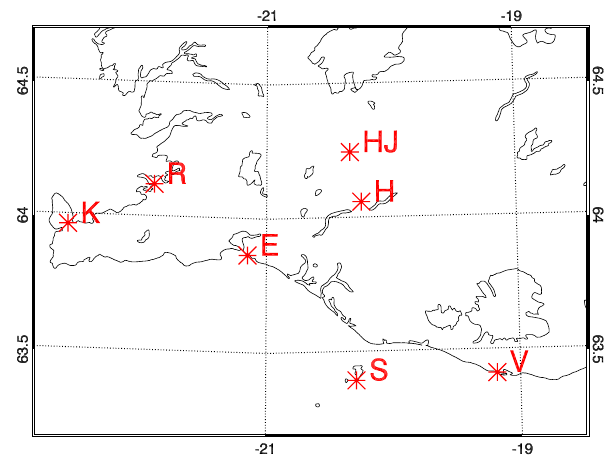
Fig. 4. Locations of manned meteorological stations (red stars) at south-western Iceland. The red letters indicate station names: (K) Keflavíkurflugvöllur, (R) Reykjavík, (E) Eyrarbakki, (HJ) Hjarðar- land, (H) Hæll, (S) Stórhöfði and (V) Vatnsskarðshólar.